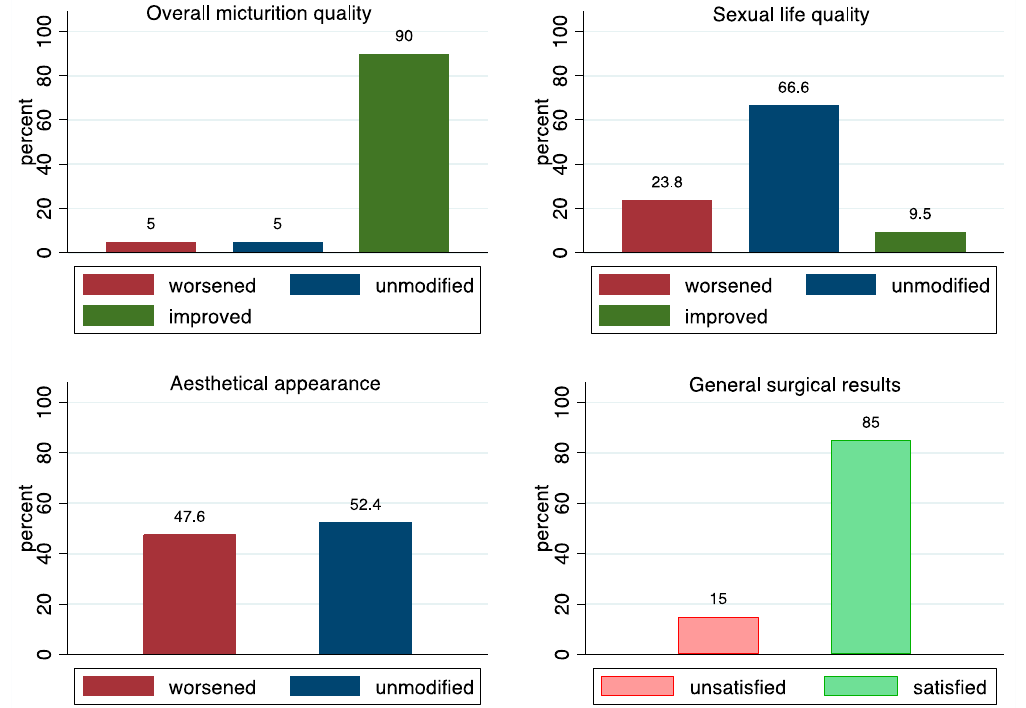
Figure 2. The figure summarizes patients’ answers to the questionnaire. The bars represent the per- centage respective to the overall number of answers per question ( n =